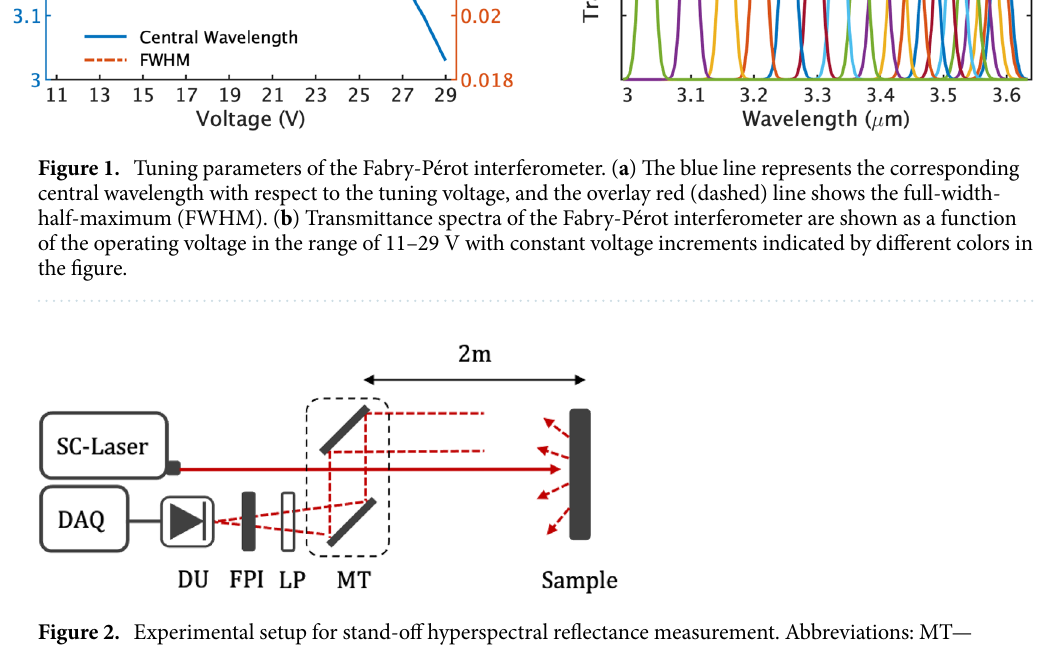
Figure 2. Experimental setup for stand-off hyperspectral reflectance measurement. Abbreviations: MT— mirror telescope, LP—longpass filter, DU—detection unit, FPI—Fabry-Pérot interferometer and DAQ—data